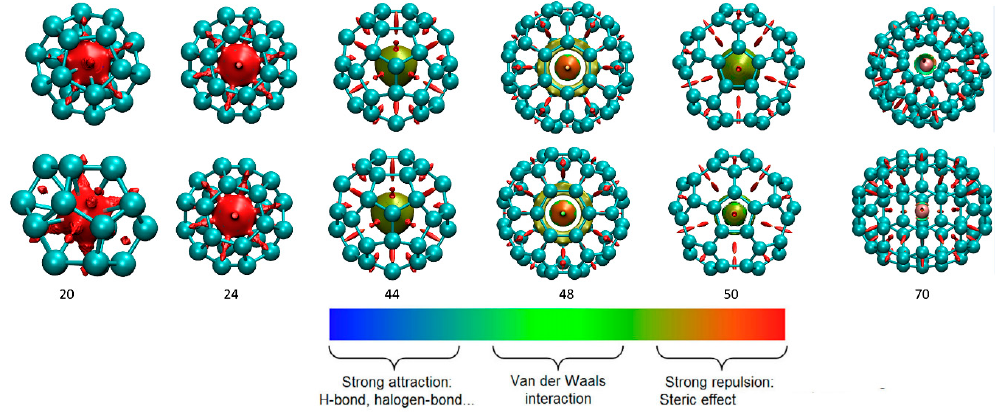
Figure 4. RDG of Li@C n ( up ) and Li + @C n ( down ).